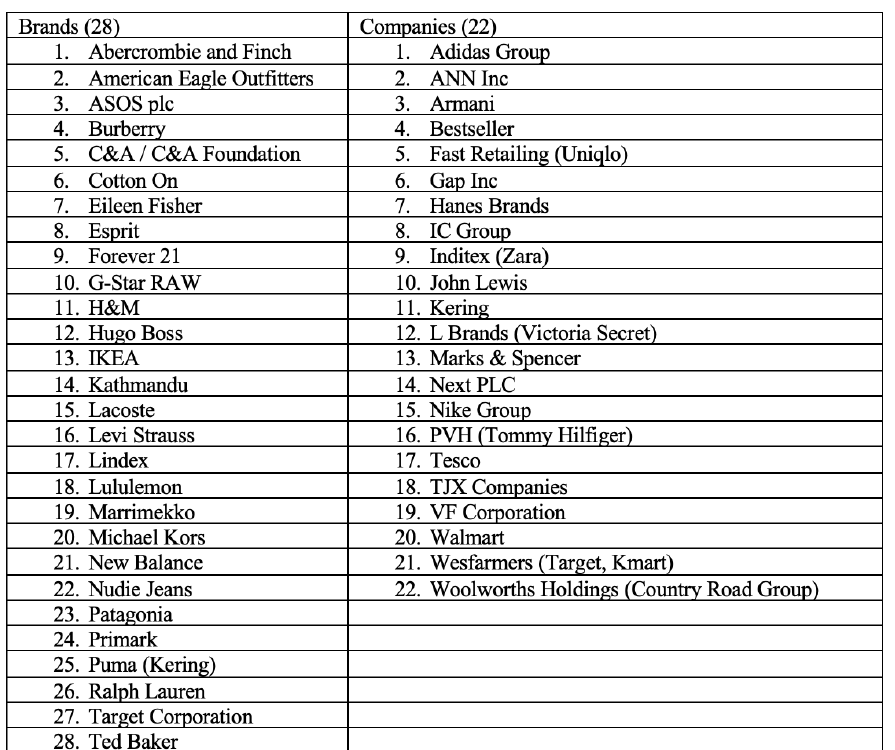
Table 1. Retailer